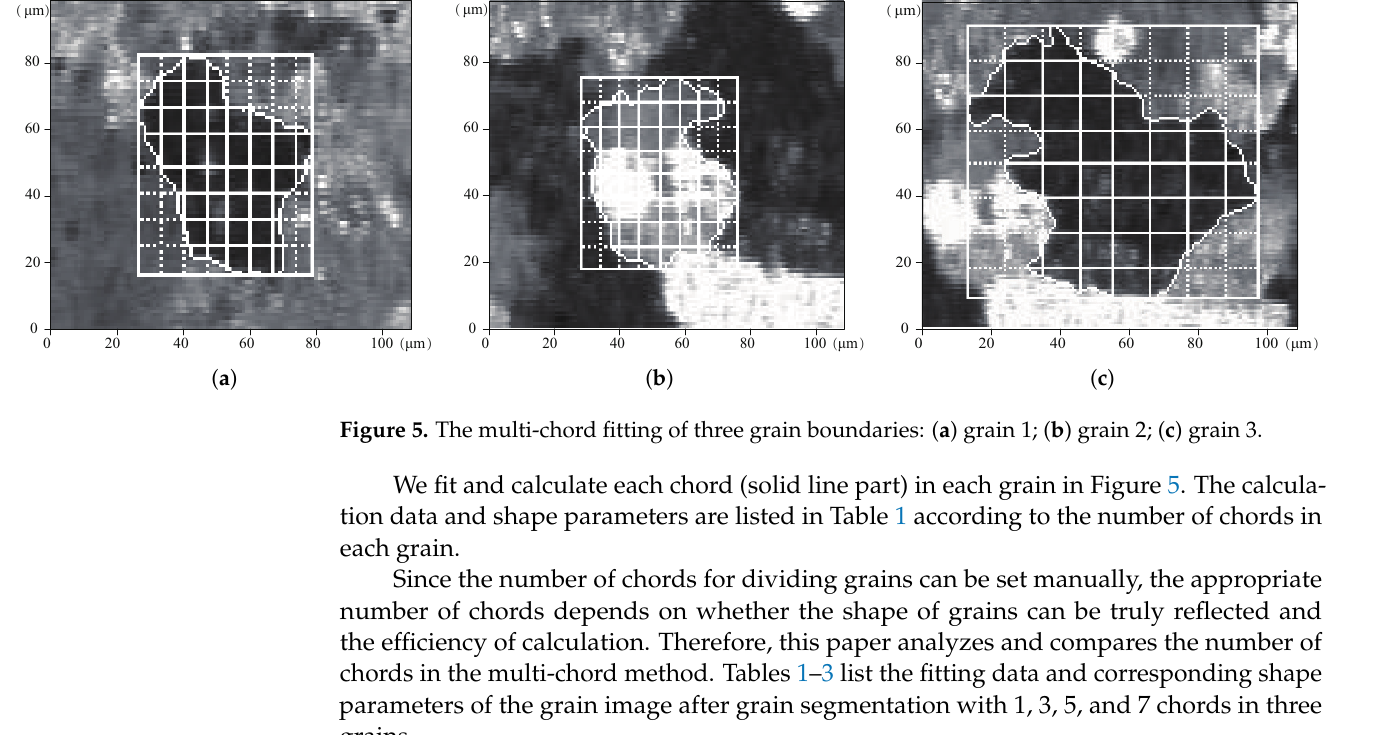
ratio of the grain, i.e., the grain shape parameter. Figure 5 is the schematic diagram of irregular grain boundary multi-chord method fitting.